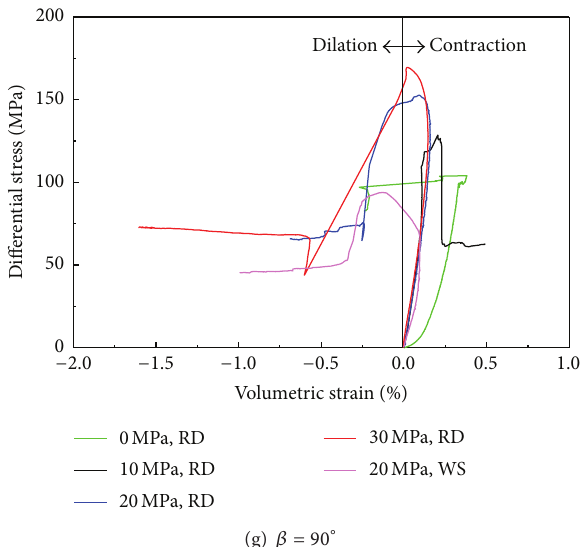
Figure 11: The differential stress-volumetric strain curves of dry and saturated shale samples of various angles, 𝛽 , tested under different confining pressures.